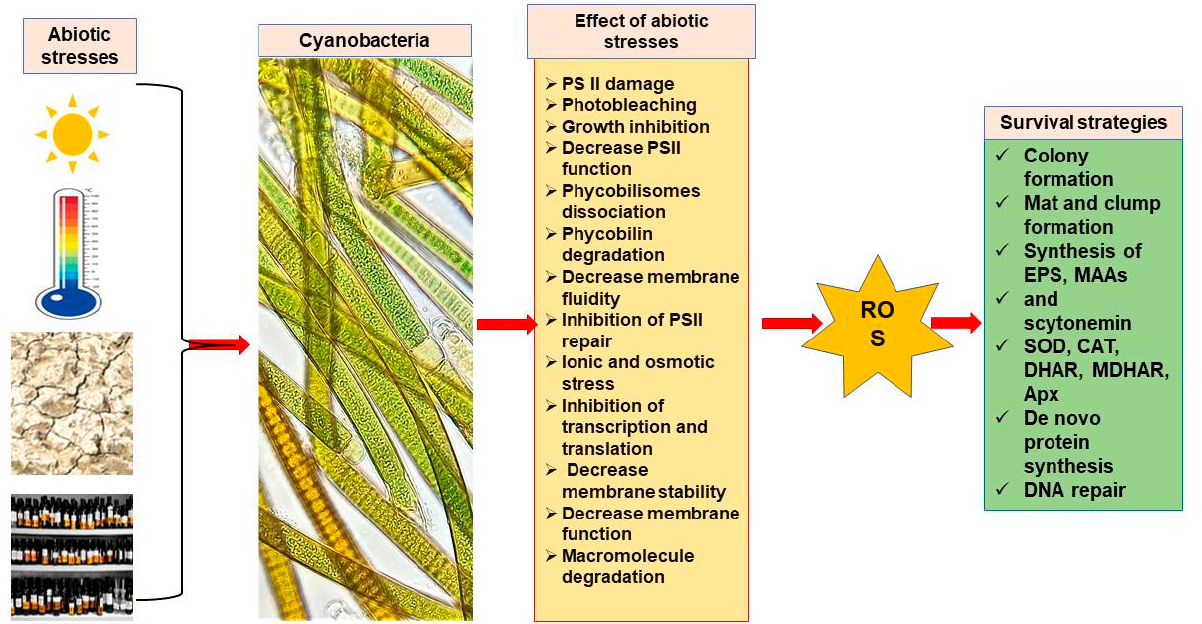
Figure 1. The overview of strategies, followed by cyanobacterial strains to cope with different abiotic stresses.